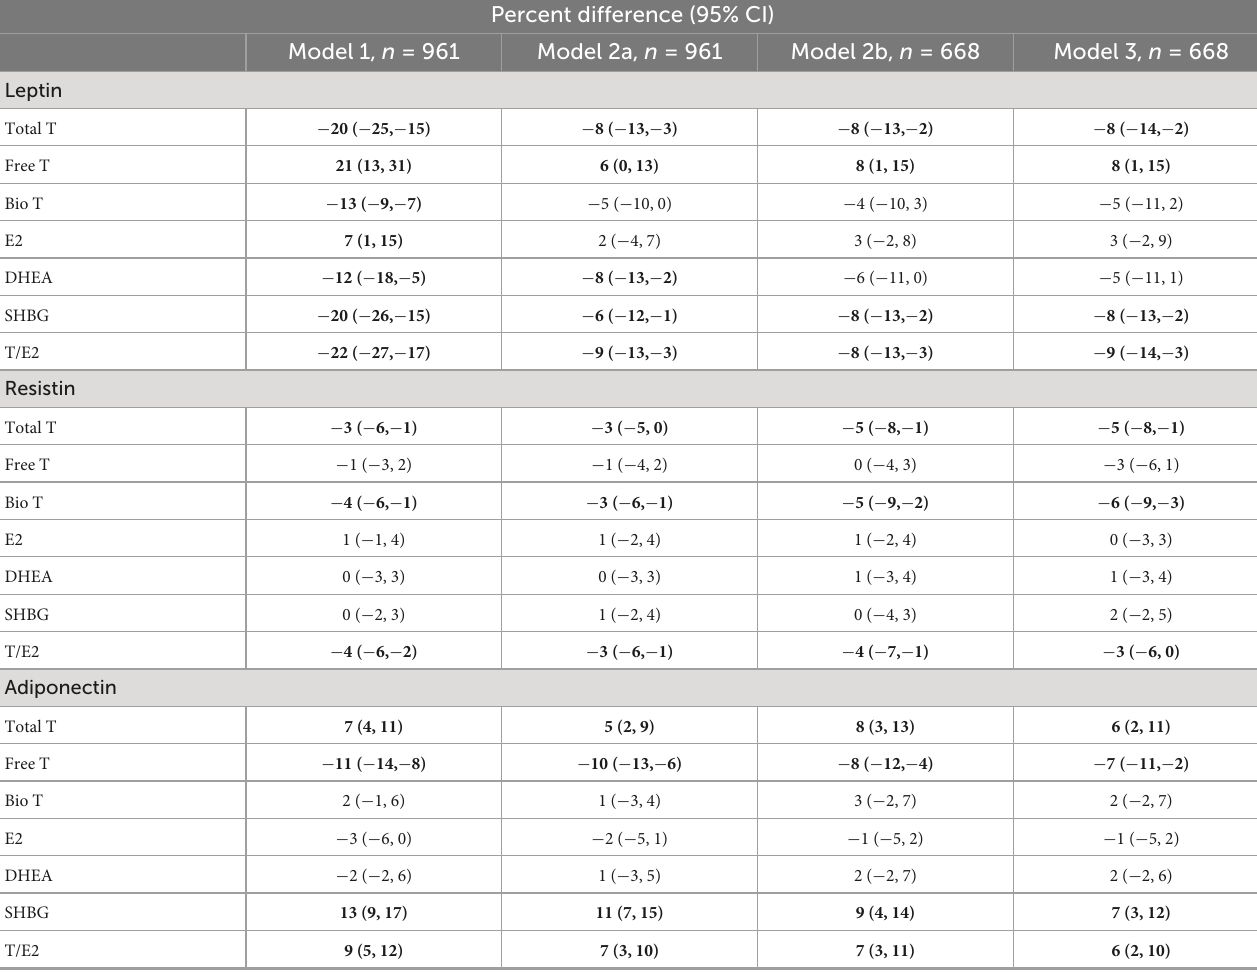
TABLE 3 Multivariable-adjusted association between sex hormones and adipokines in men.